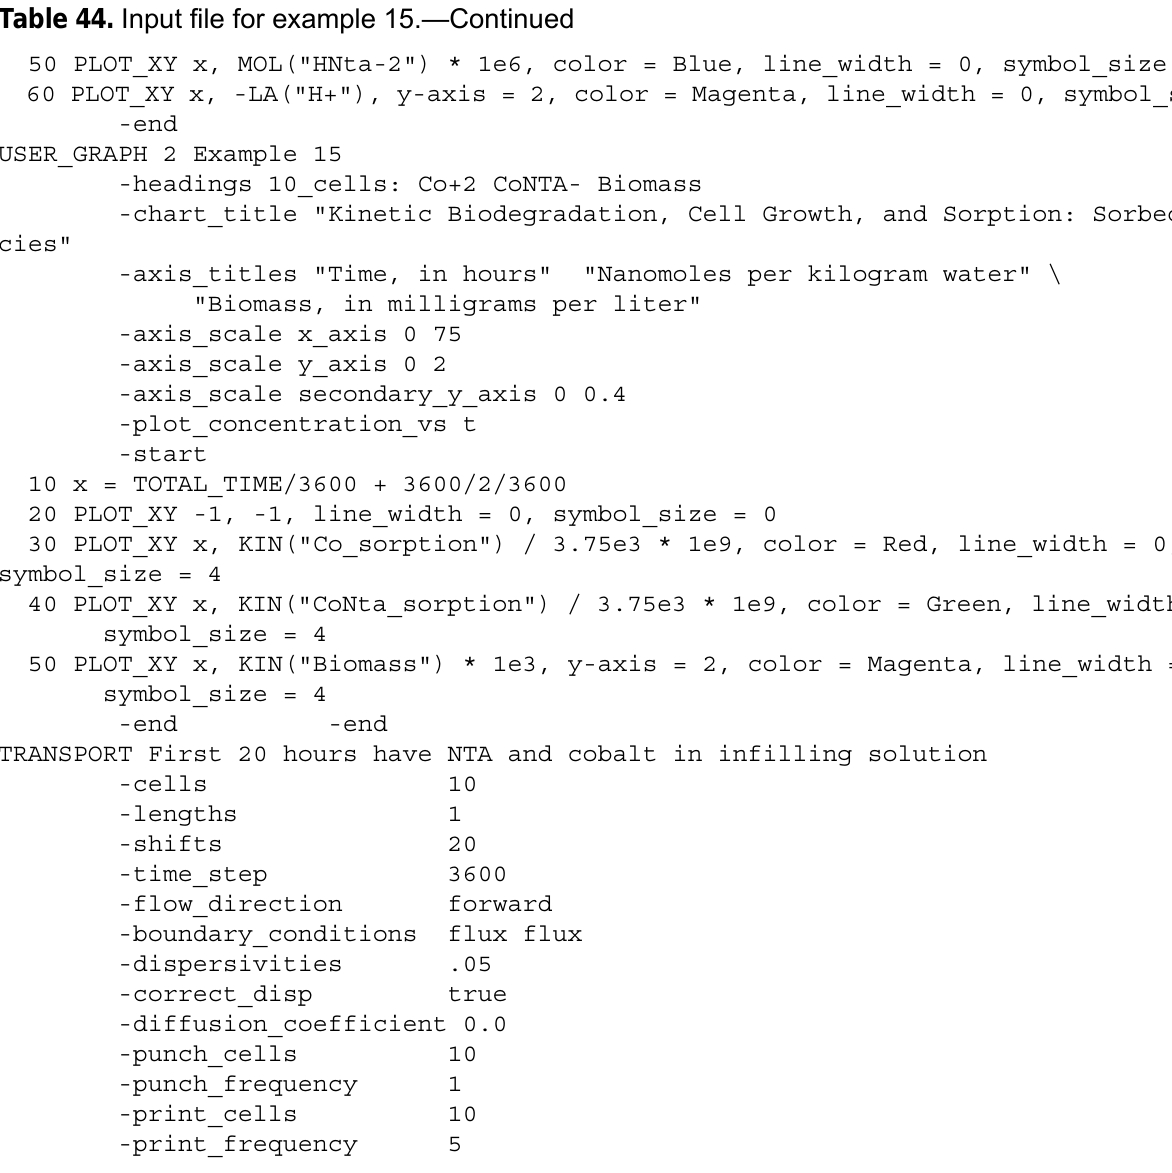
Table 44. Input file for example